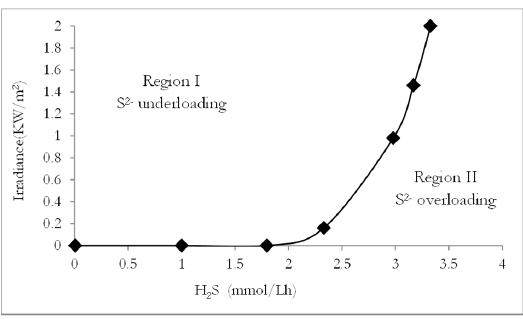
Figure 4. The van Niel curve (adapted from [130]).